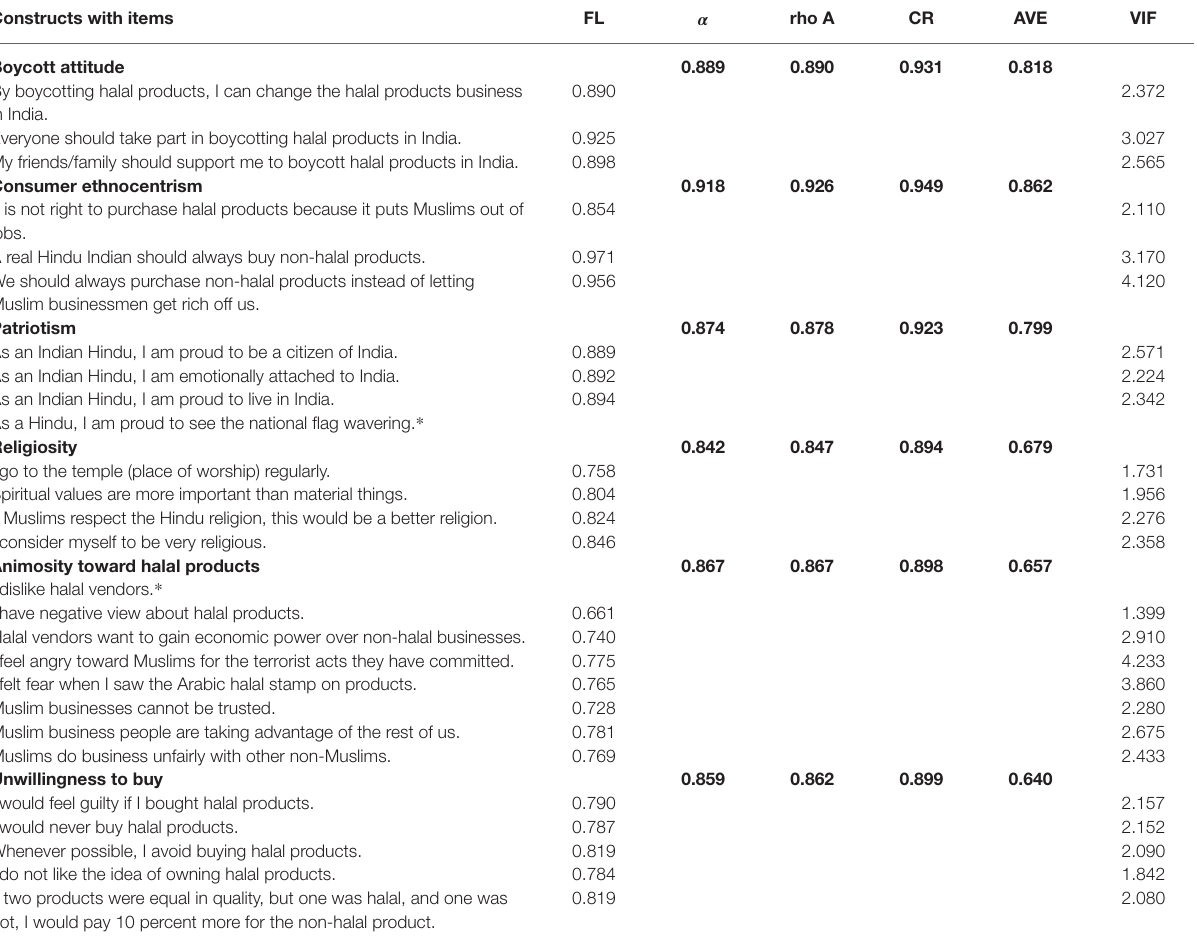
TABLE 1 | Factor loadings (FL), Cronbach alpha ( α ), composite reliability (CR), Dijkstra–Henseler’s rho (rho A), average variance extract (AVE), and variance inflation factor (VIF). Constructs with items